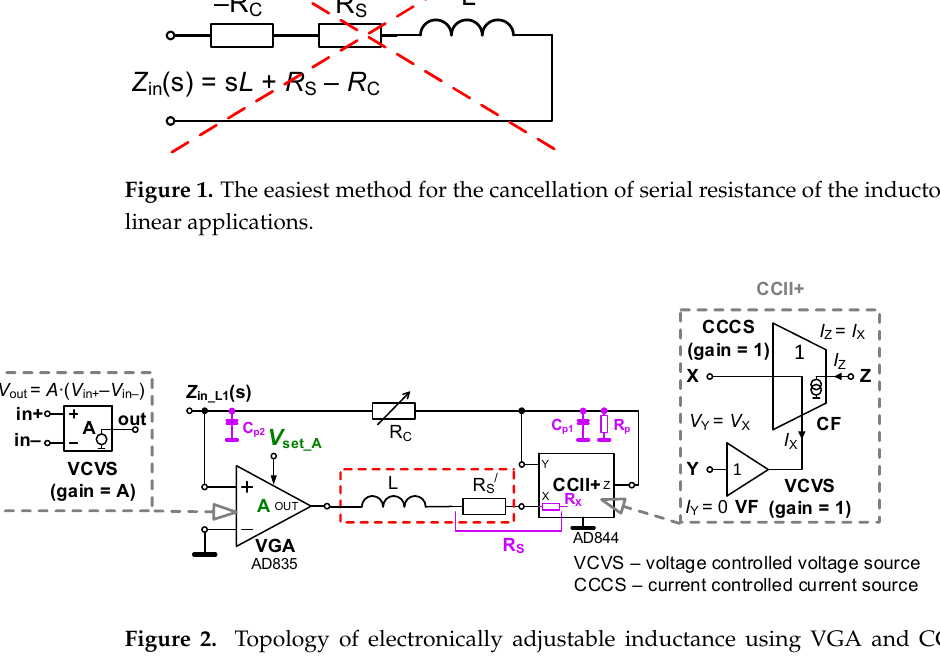
Figure 3. Topology of electronically adjustable inductance value and R S cancellation using two VGAs and CCII+.